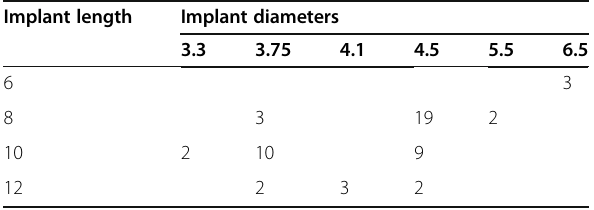
Table 1 Distribution of implants according to length and diameter Implant length